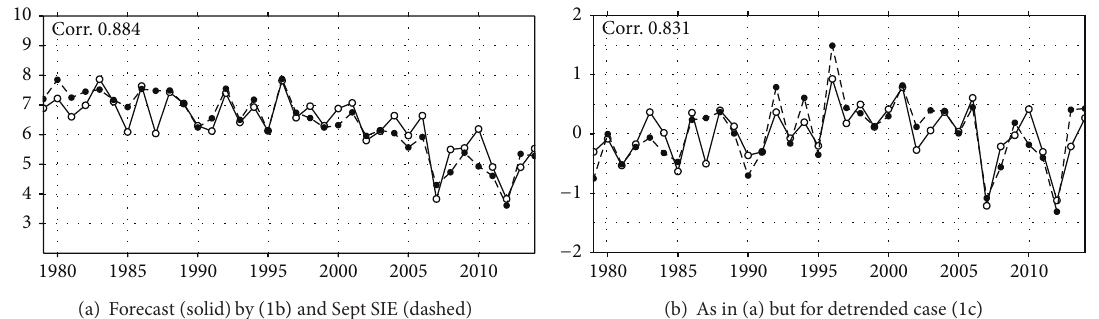
Figure 13: The time series of SIE observed in September and a multiple regression forecasted SIE in September during 1979–2014: (a) the observed versus predicted September SIE based on two variables the JJ and JA SIE and (b) as in (a) but for the variables detrended case.